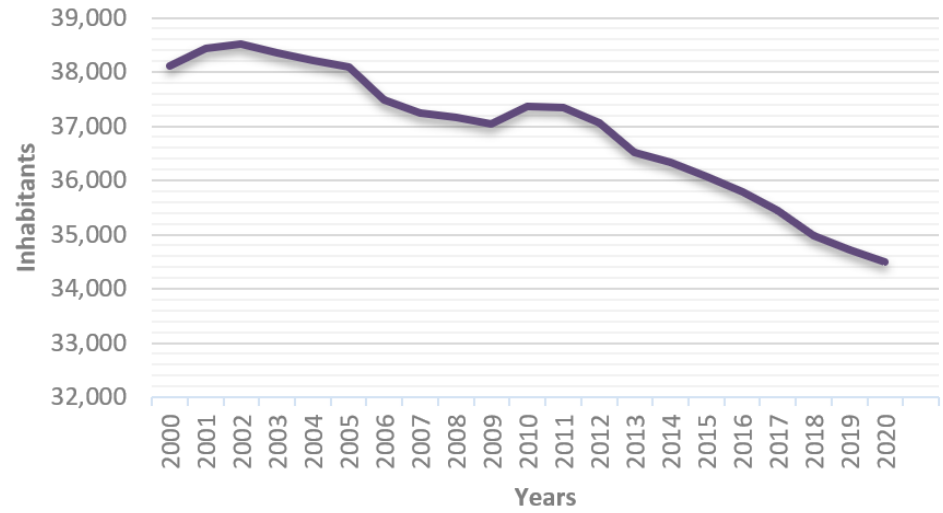
Figure 4. Evolution of the population (2000–2020) in the tourist territory of Valle del Jerte-La